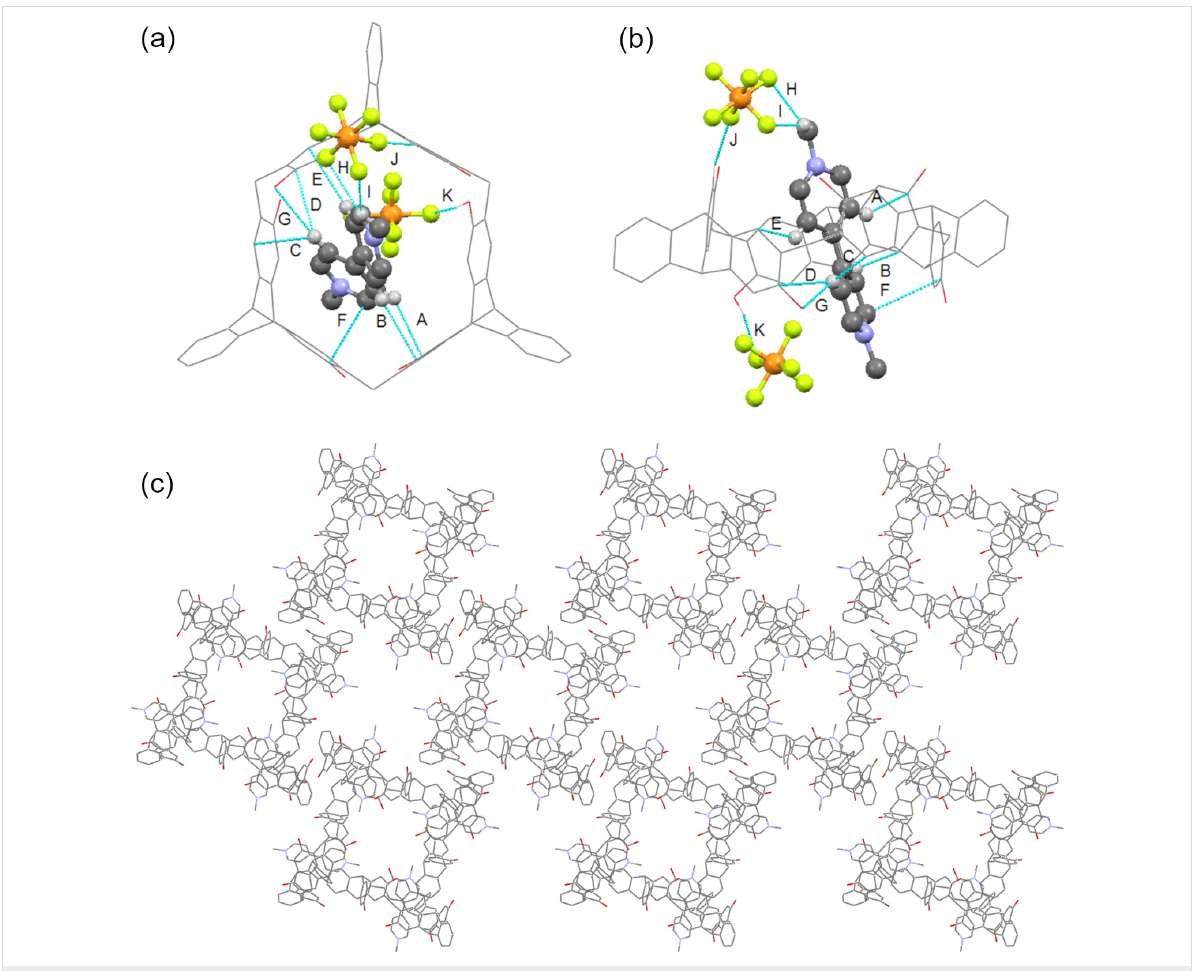
Figure 4: Crystal structure of complex H1·G1 . (a) Top view, (b) side view, and (c) packing viewed along c -axis. Blue lines denote the non-covalent interactions between H1 and G1 . Solvent molecules and hydrogen atoms not involved in the non-covalent interactions were omitted for clarity.